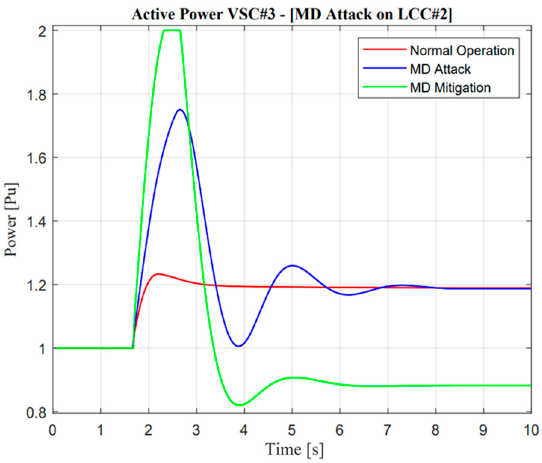
Sensors 2023 , 23 , x FOR PEER REVIEW 22 of 27